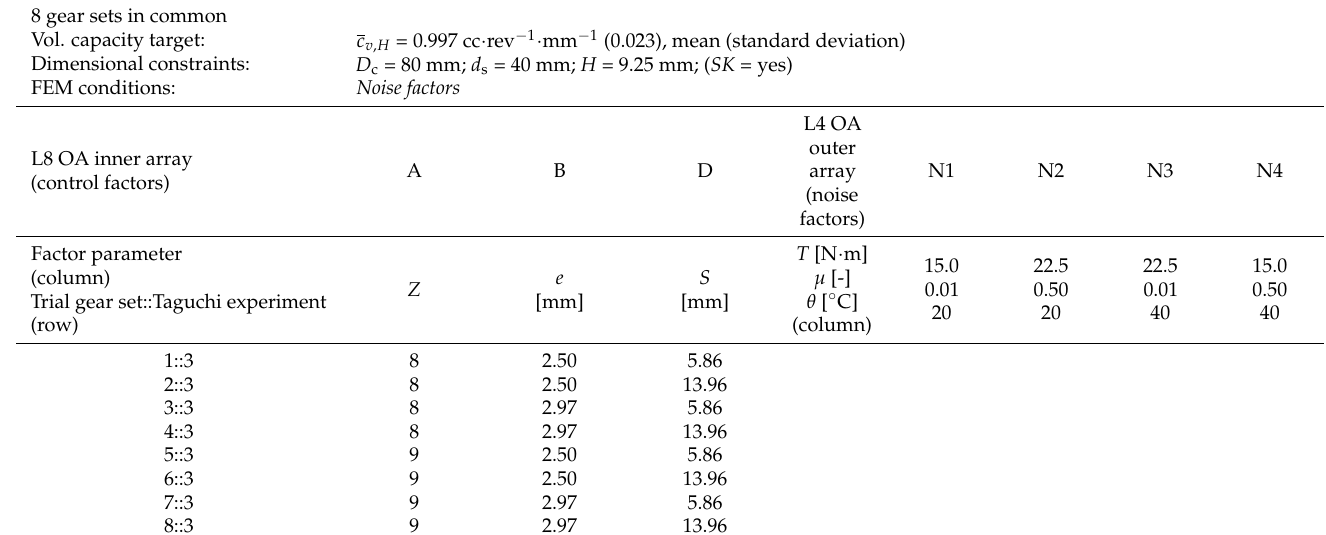
Table 6. The parameter design table of the third Taguchi experiment. (Please refer to Nomenclature section and Figure 2).